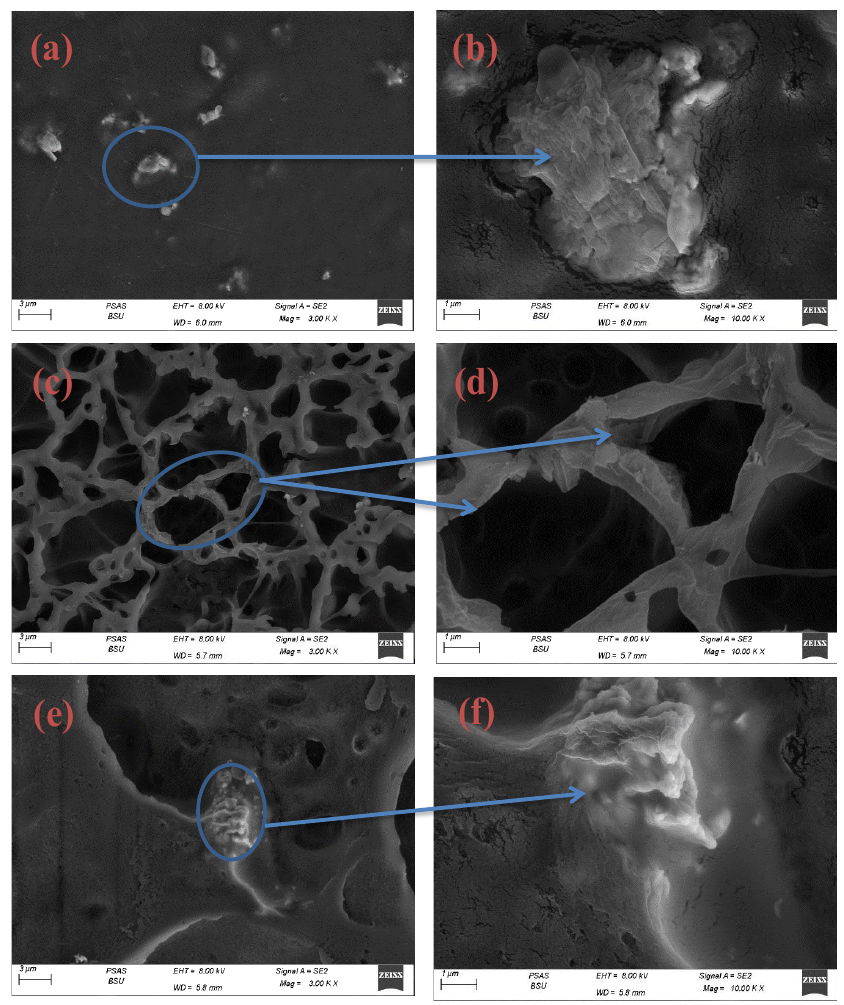
Figure 3. SEM micrograms of CA film casting: ( a , b ) Sm 2 O 3 @CA ( c , d ) Sm 2 O 3 /MgO@CA, ( e , f ) Sm 2 O 3 /MgO/GO@CA .